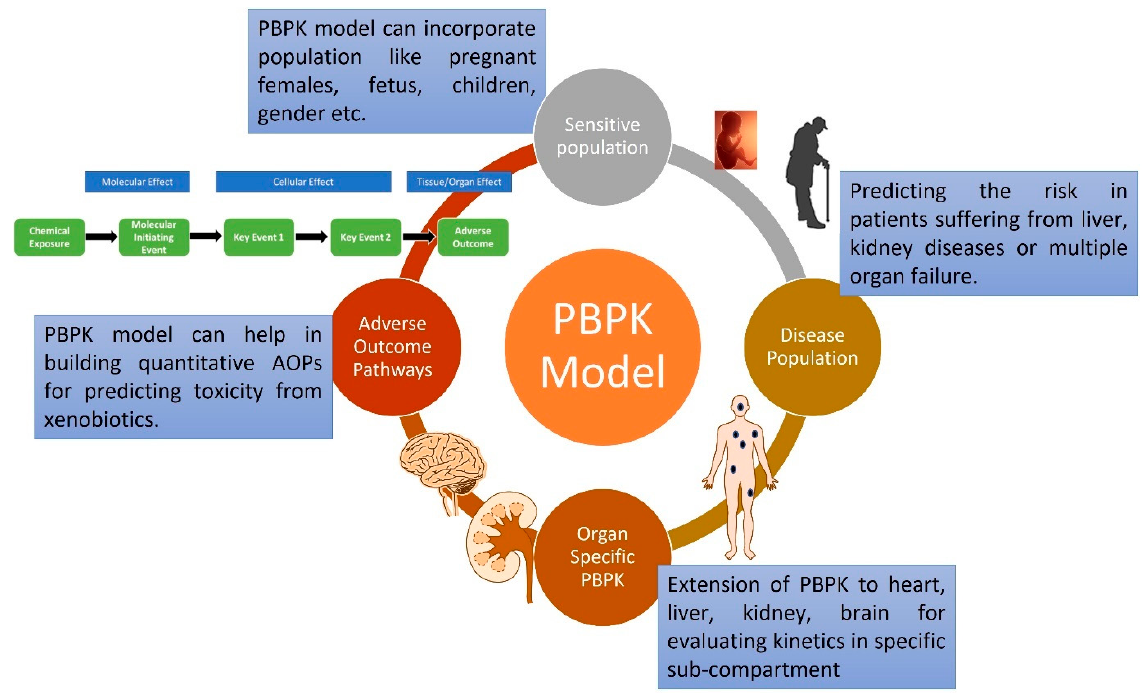
Figure 5. Applications of PBPK models in different fields (sensitive populations, diseased populations, organ-specific and adverse outcomes) for therapeutics and toxicological risk assessment.